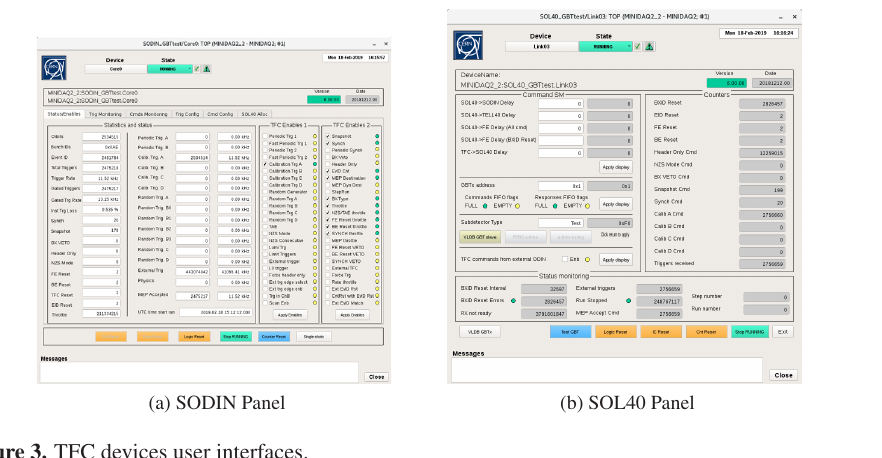
Figure 3. TFC devices user interfaces.